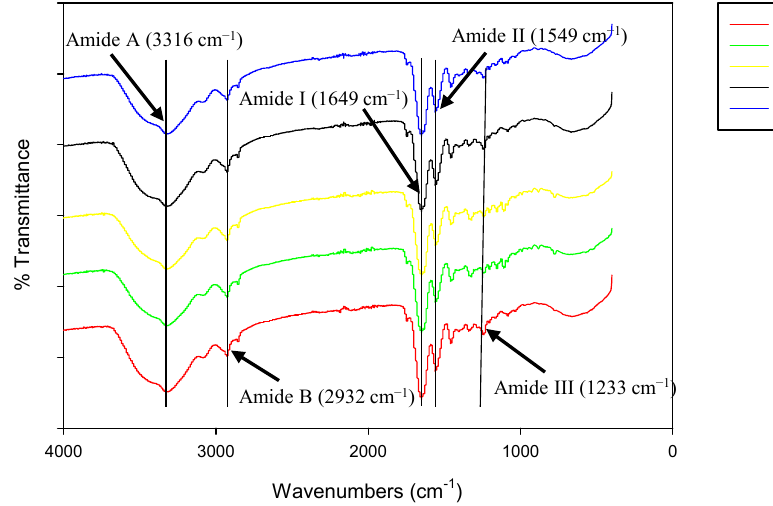
Figure 3. The FTIR spectra of Col/Elas sca ff olds crosslinked by 0.1% genipin.